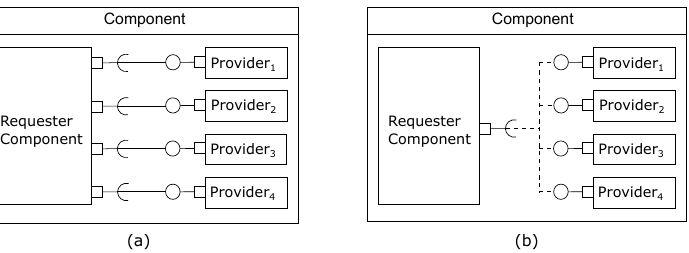
Figure 22. Sending requests to providers in a round-robin order: ( a ) Existing design: Requester component sends requests in round-robin order using multiple ports. ( b ) Updated design: Using an enhanced connector to send requests in round-robin